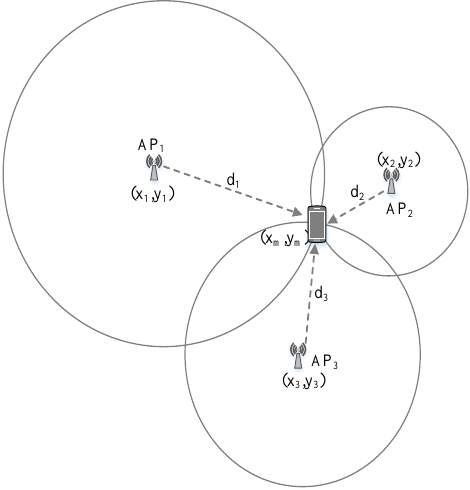
Figure 2. Localization based on time of arrival (TOA)